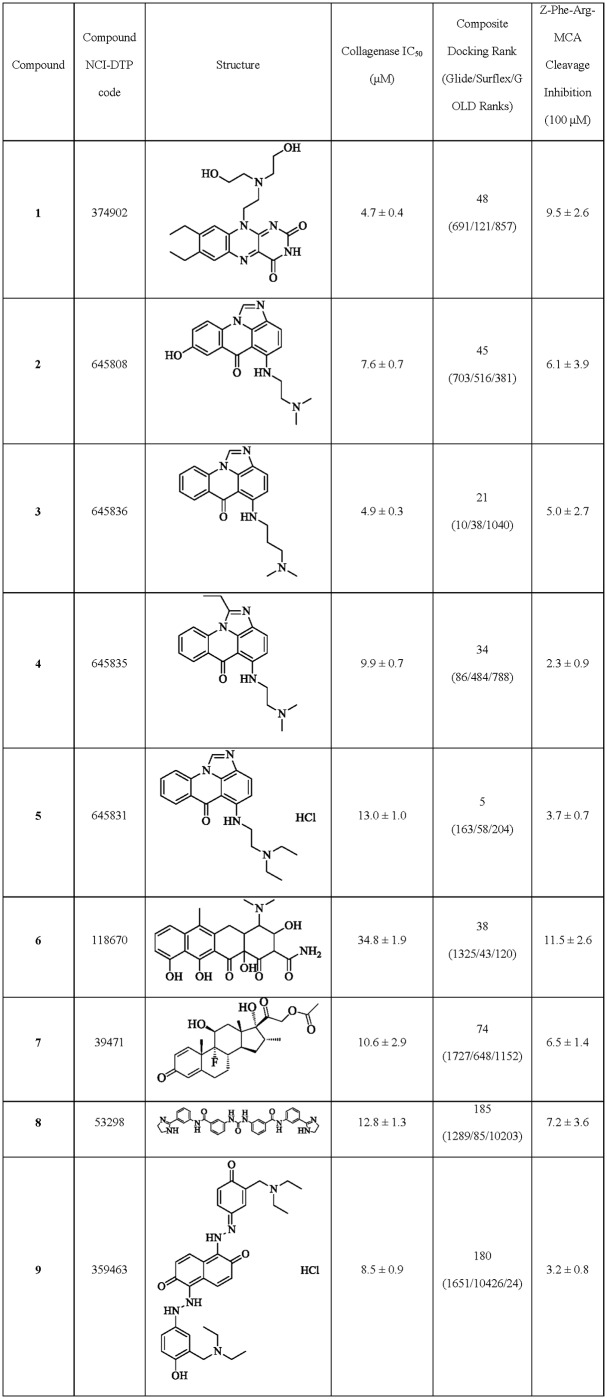
Summary of collagenase inhibitors identified through composite docking from the NCI-DTP repository.